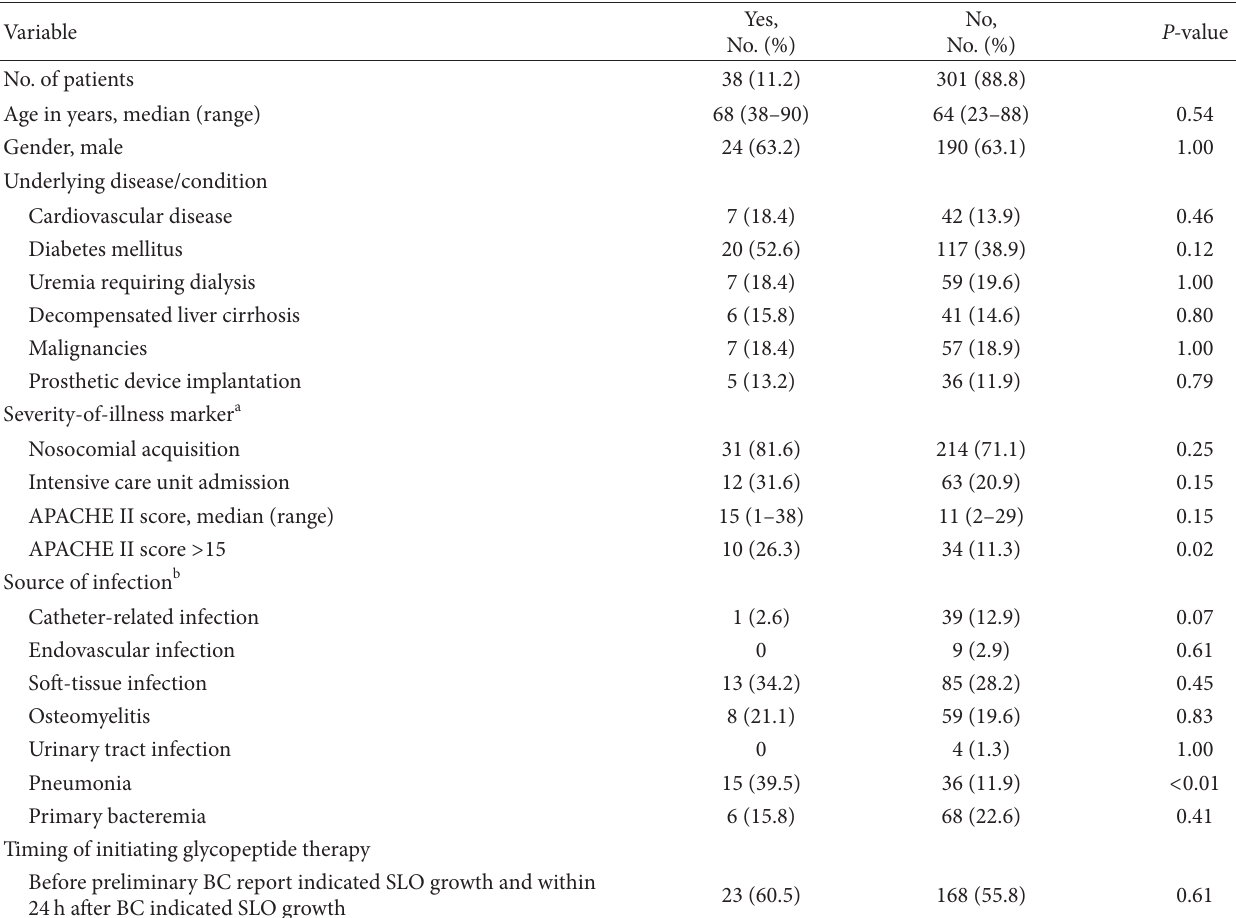
T 3: Variables associated with 14-day infection-related